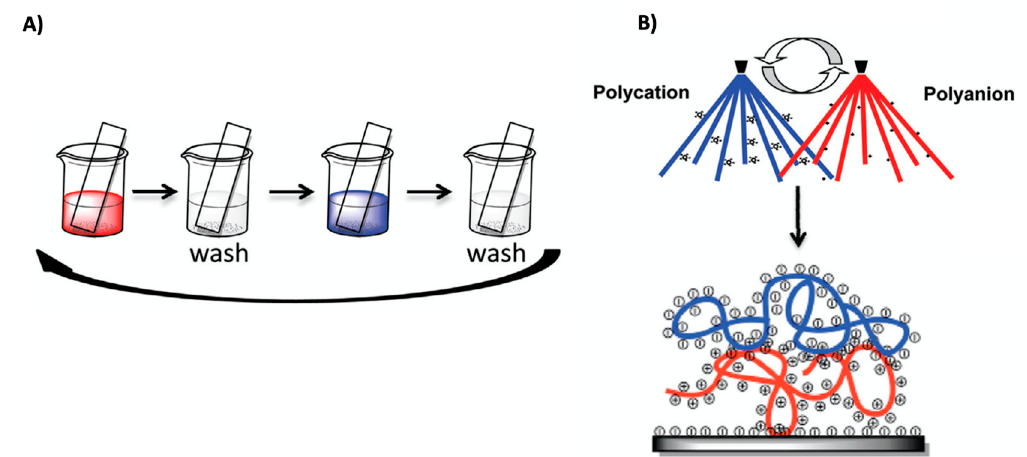
Figure 2. Layer-by-layer approach for PEM fabrication: a negatively charged substrate is alternately immersed ( A ) (or sprayed ( B ), for instance) in polycation and polyanion solutions, respectively. Washing steps are to remove unbound polyelectrolytes. Colour-coding: polyanion (blue); polycation (red). Figure adapted with permission from reference [23], copyright © 2020 Elsevier Ltd.